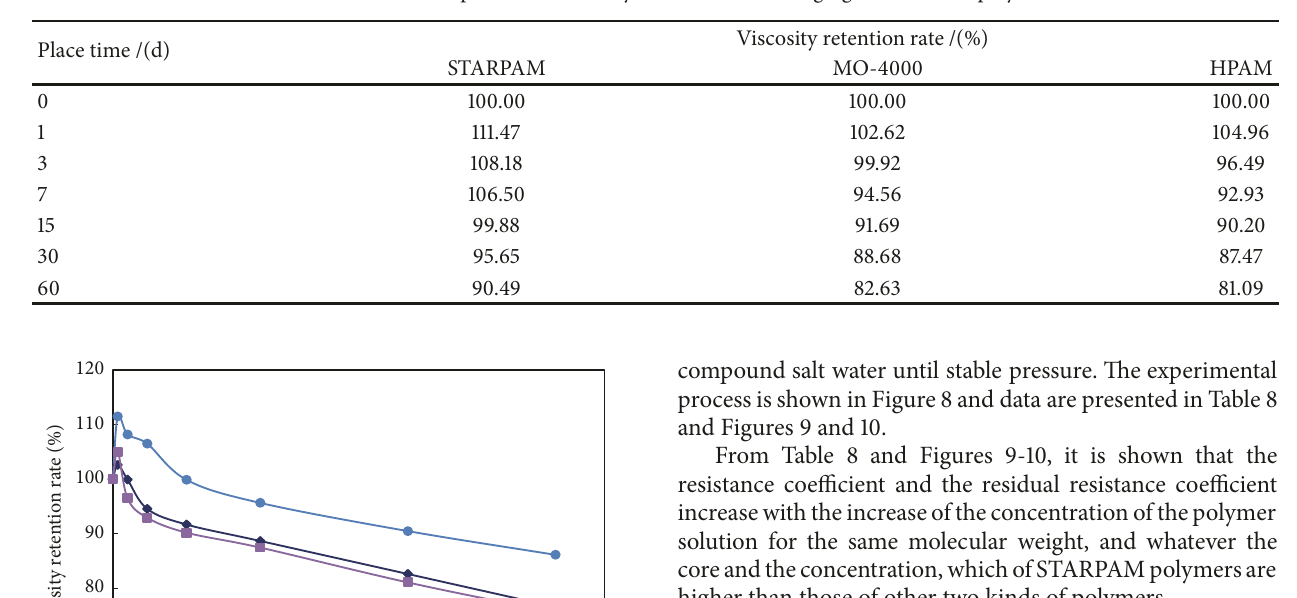
Table 7: The relationship between viscosity retention rate and aging time of three polymers.